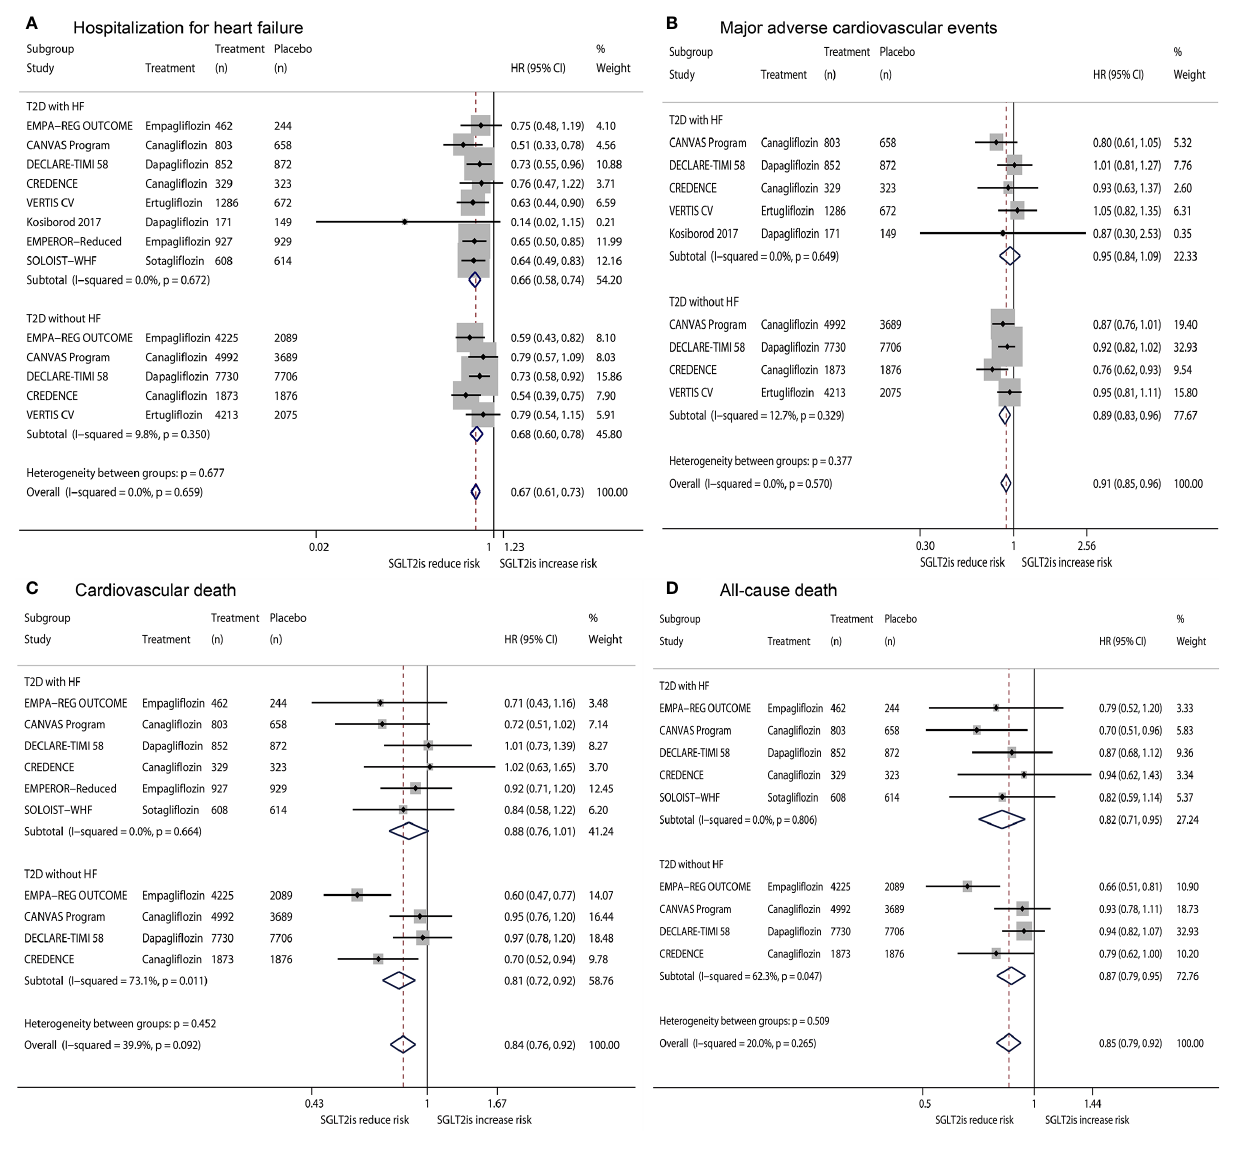
FIGURE 1 | Fixed-effects meta-analysis of the effects of SGLT2is on hospitalization for heart failure (A) , major adverse cardiovascular events (B) , cardiovascular death (C) , and all-cause death (D) in T2D patients, strati fi ed by the status of HF. SGLT2is = sodium-glucose cotransporter 2 inhibitors. T2D, type 2 diabetes; HF, heart failure; HR, hazard ratio; CI, con fi dence